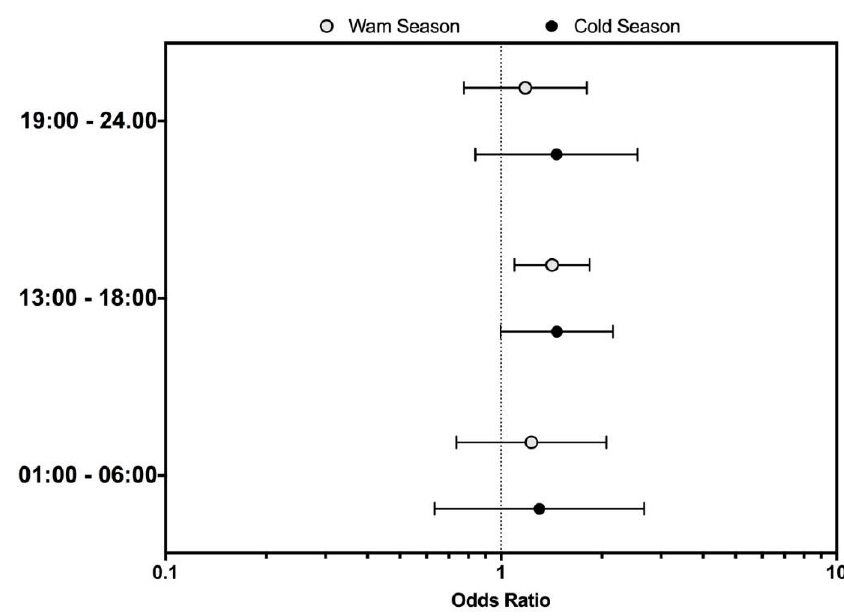
Figure 1. Occupational injuries (OIs) among the EMRO workers stratified by time of day and the season of occurrence in the Autonomous Province of Trento (APT) between 2000 and 2013.